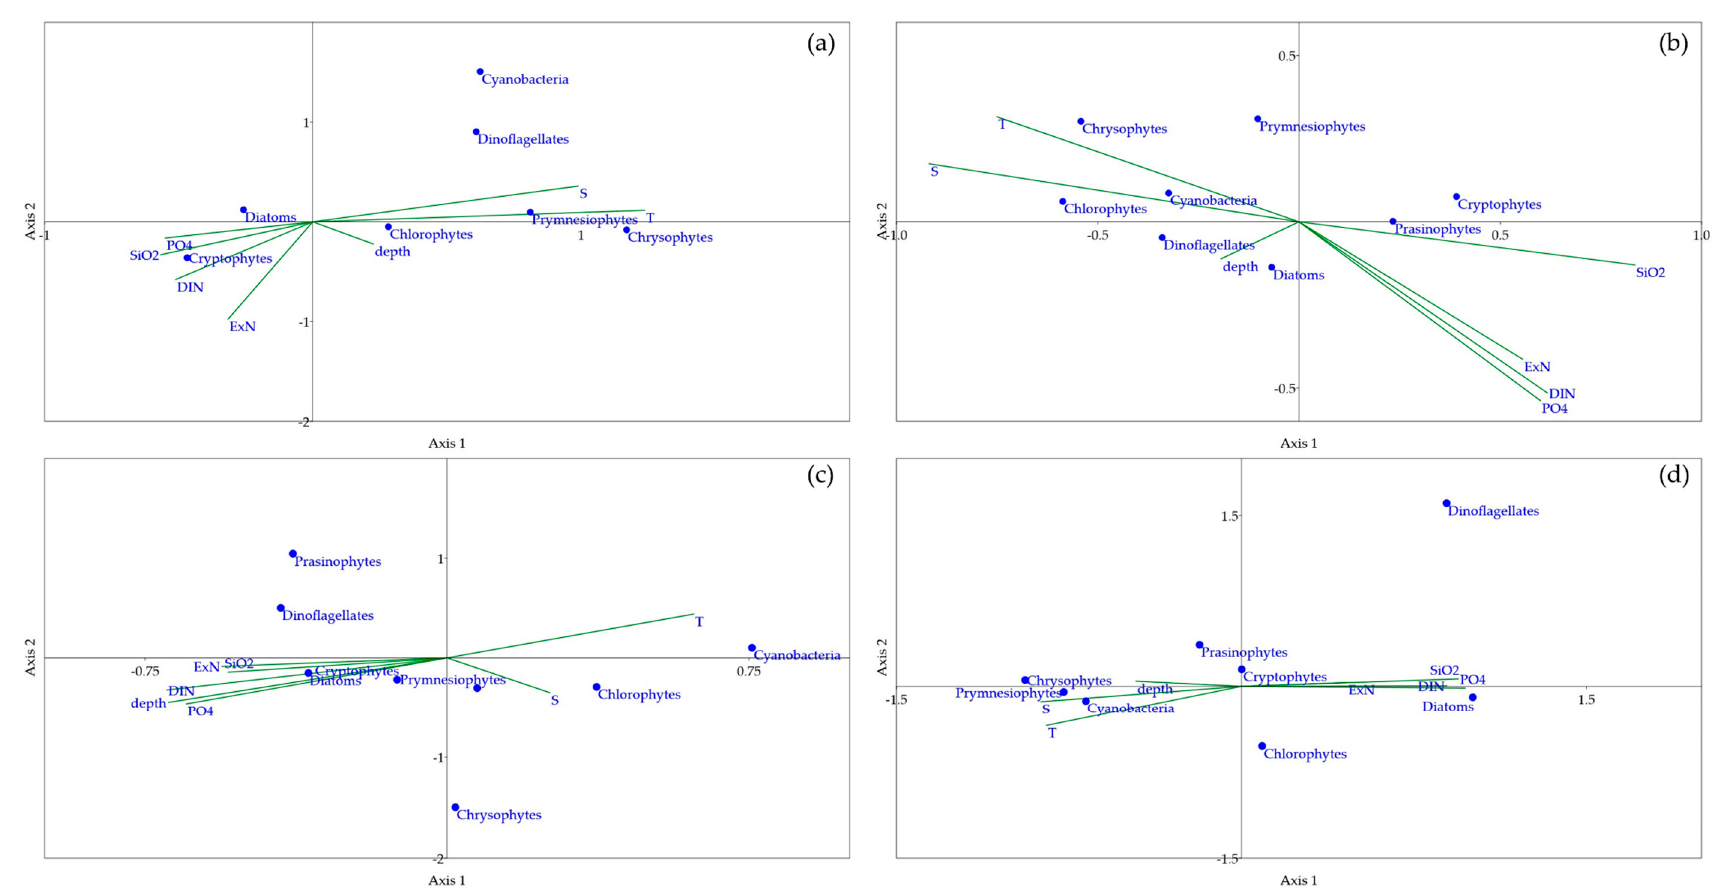
Figure 7. Canonical correspondence analysis of seasonal phytoplankton communities and environmental parameters measured at each cruise period in the northern East China Sea ( a ) February ( b ) May ( c ) August ( d ) November.